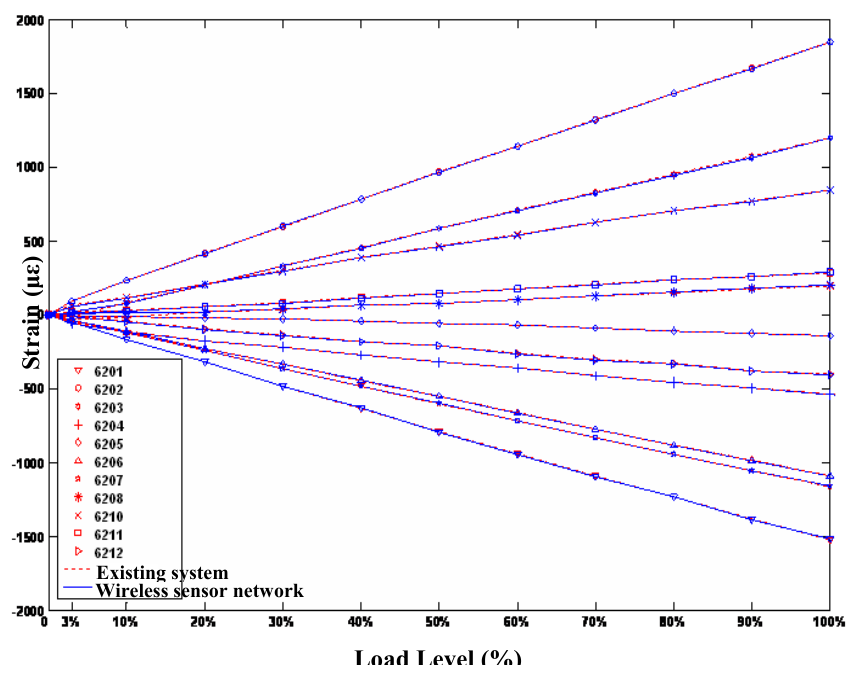
Figure 14. Test data comparison between WSN and the cable-based